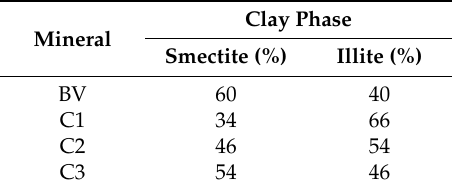
Table 2. Semi-quantitative mineralogical composition of the clay phases in the raw starting aluminosilicates. Clay Phase Mineral